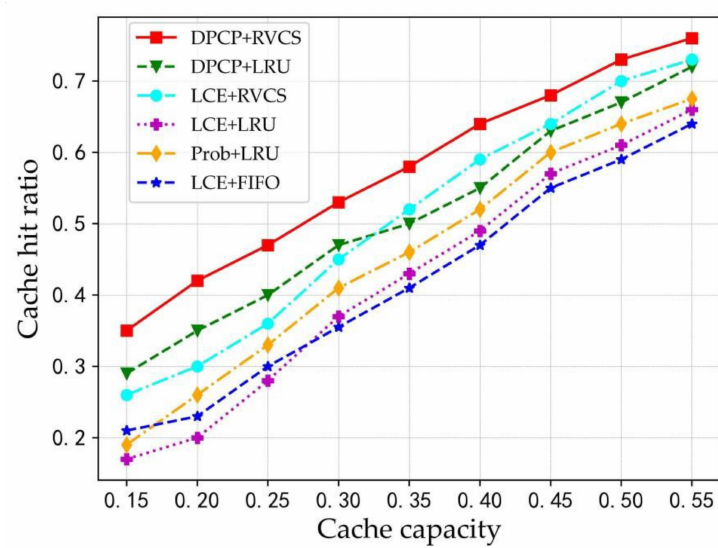
Figure 7. The impact of the Zipf distribution parameters on the cache hit ratio.